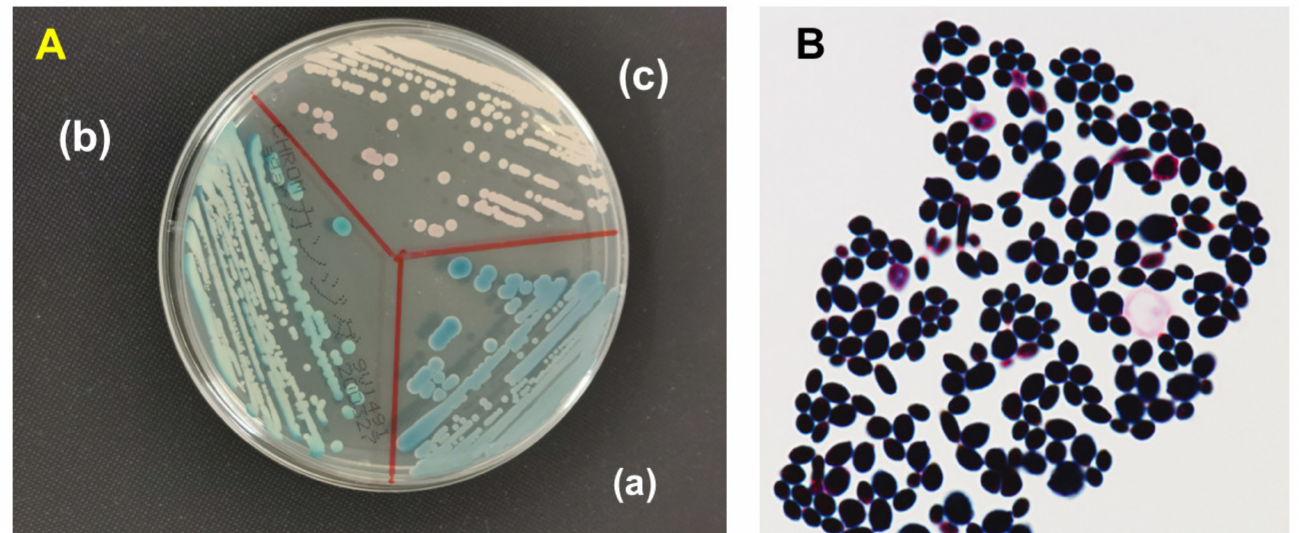
Figure 1. The plate was incubated at 35 ◦ C for 48 h, ( A ) Colony characteristics of Lodderomyces elongisporus (a), Candida parapsilosis (b) and C. albicans (c) on CHROMagar Candia (CHROMagar, Paris, France). ( B ) Gram-stain of L. elongisporus from aerobic blood culture bottle. Gram-positive budding yeast were seen (magnification ×